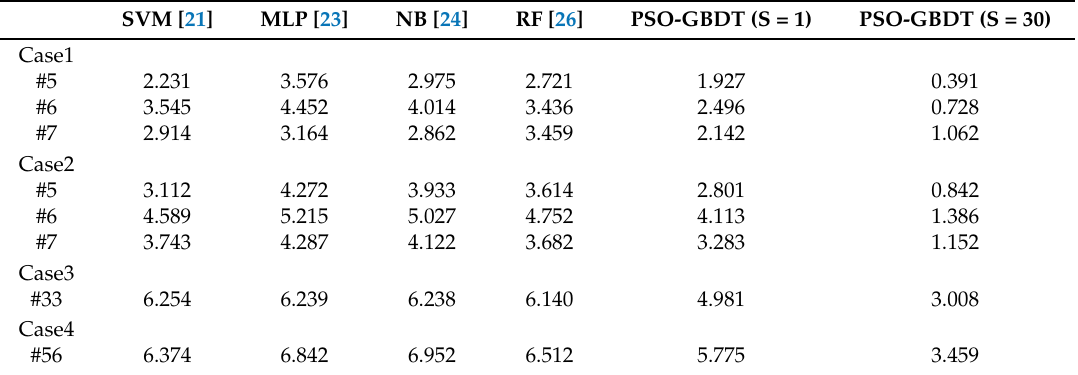
Table 4. Root mean square errors (RMSEs) of the RUL prediction results with different